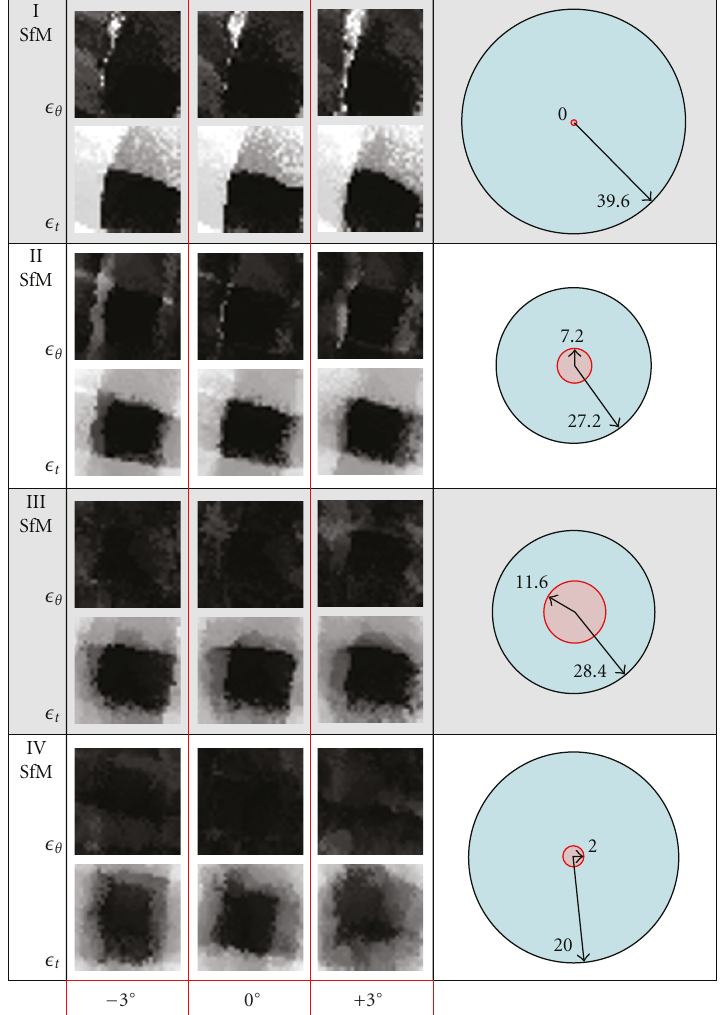
Figure 10: Results of tests with the calculated SfM point cloud. As described in Figure 8 for each landmark the error images are given. Additionally the radii of convergence are shown for each landmark on the right